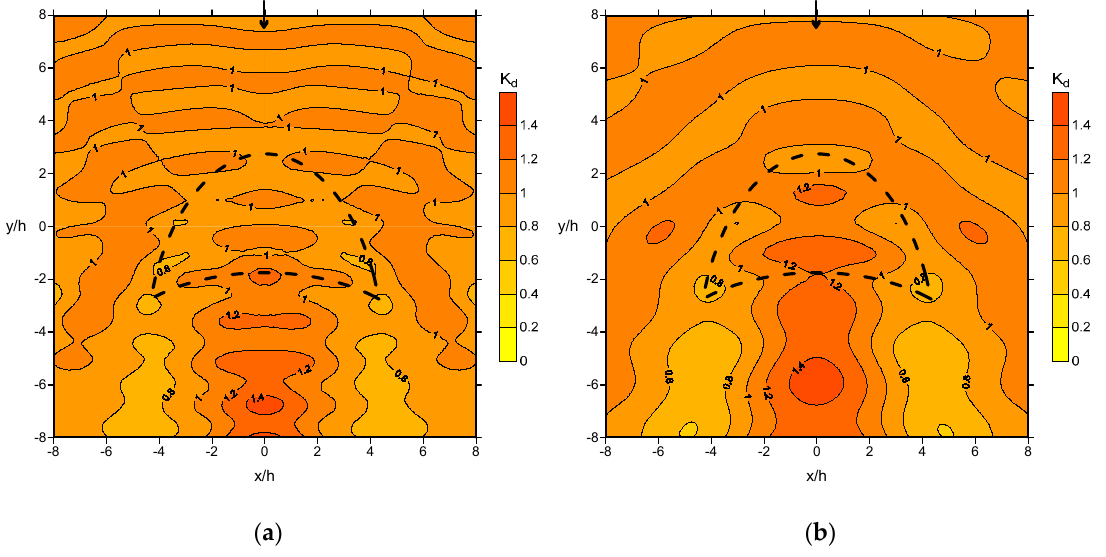
Figure 11. Numerical wave fields of the crescent-shaped plate submerged 0.5 h below the free surface for wave conditions of ( a ) σ 2 h / g = 2.012 and ( b ) σ 2 h / g = 0.894 at normal